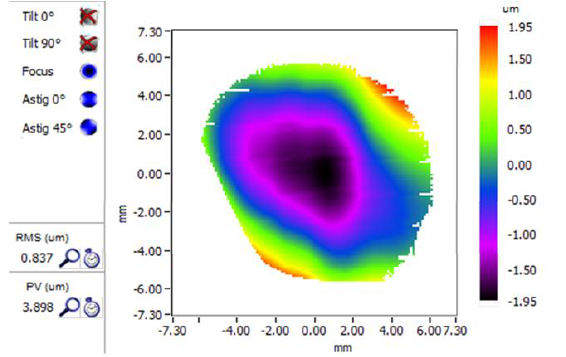
Fig. 5. SH wavefront map of a 2mm thick glass with a block print edge. WFE = 837 nm RMS